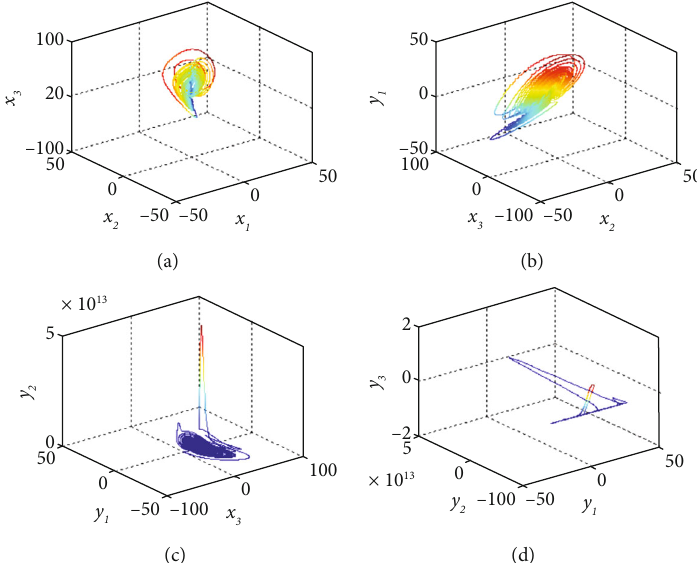
Figure 9: The chaotic trajectory of the unidirectionally coupled Chen system with the exponential manifold y = ½ x space: (a) x